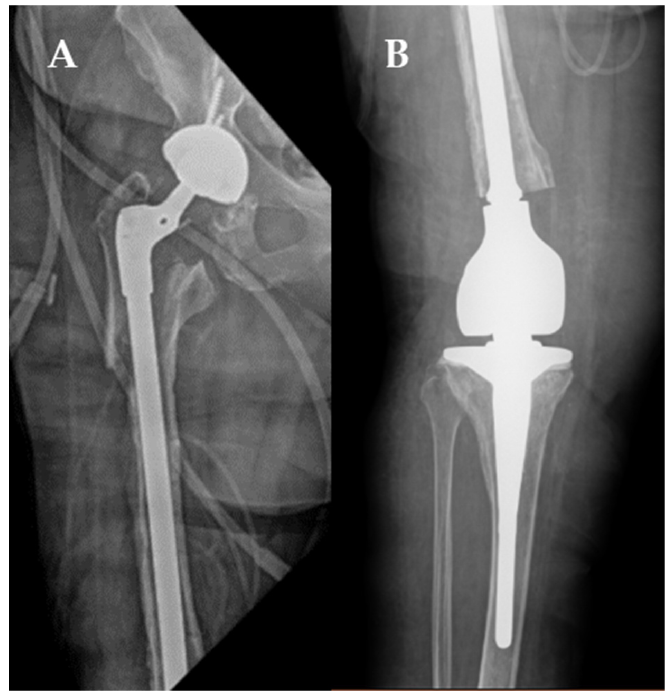
Figure 3. After cure of recalcitrant MRSA PJI and implantation of right total hip arthroplasty ( A ) extending in continuity with a total knee arthroplasty ( B ).